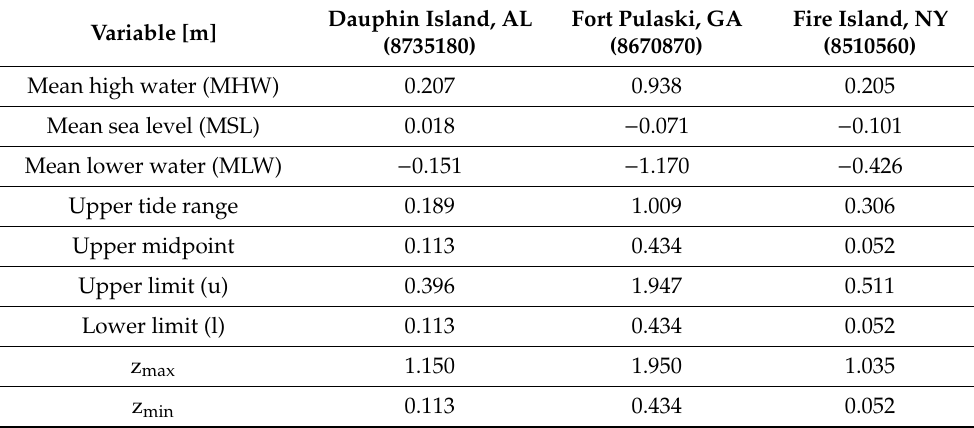
Table 5. Tidal datum and variables of Equation (1) used for salt marsh elevation